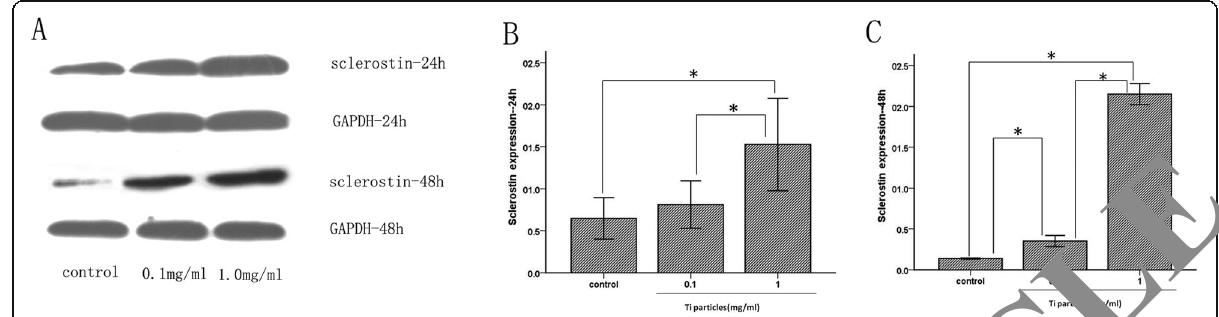
Fig. 5 Sclerostin protein expression of MLO-Y4 cells treated with Ti particles (0 (control), 0.1 mg/mL, or 1.0 mg/mL) for 24 h and 48 h. Levels of sclerostin protein were detected by Western blot, and GAPDH was used as an endogenous control. b The quantitative datafor sclerostin levels is expressed as band-density ratios compared to the control group at 24 h. Sclerostin expression was significantly higher in the 1.0 mg/mL group than the control group or the 0.1 mg/mL group (* p < 0.05). c The quantitative data for sclerostin levels is expressed as band-density ratios compared to the control group at 48 h. Treatment with 0.1 mg/mL or 1.0 mg/mL of Ti particlessignificantly increased sclerostin expression compared with the control group (* p < 0.05)